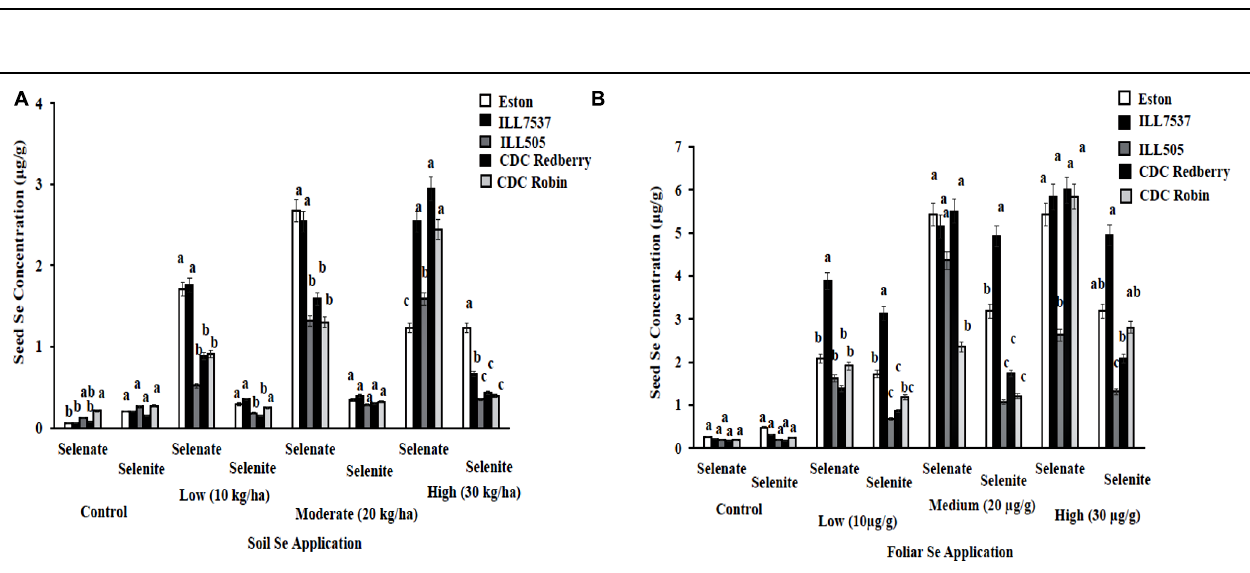
FIGURE 3 | Seed Se concentration in lentil genotypes grown under greenhouse conditions with soil application (A) and foliar application (B) of different rates and forms of Se. Each genotype (bars) for each Se rate and form followed by different letters are significantly different at P < 0.05.